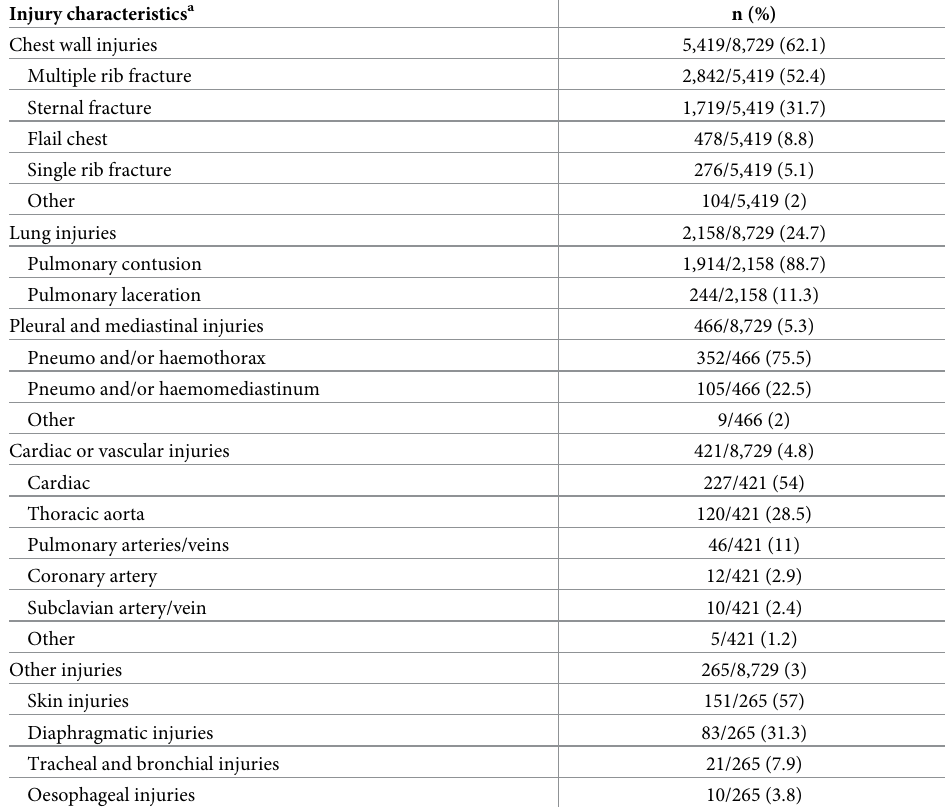
Table 2. Description of thoracic injuries in the AIS Thorax � 2